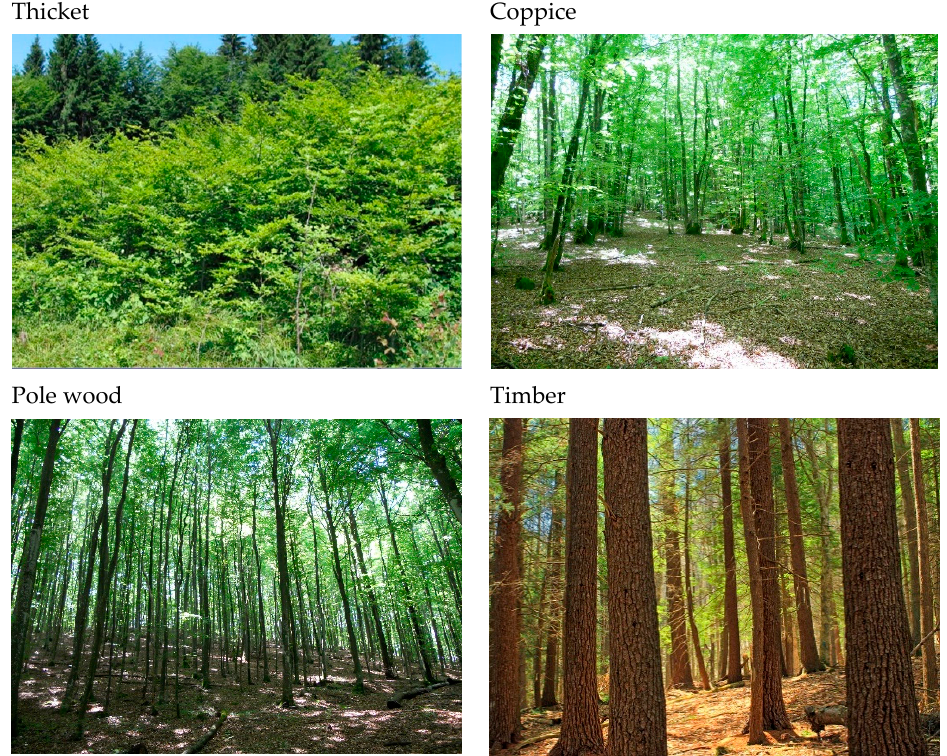
Figure 3. Forest development stages. References for photos: [40] (thicket), [41] (coppice), [42] (pole wood), [43] (timber).